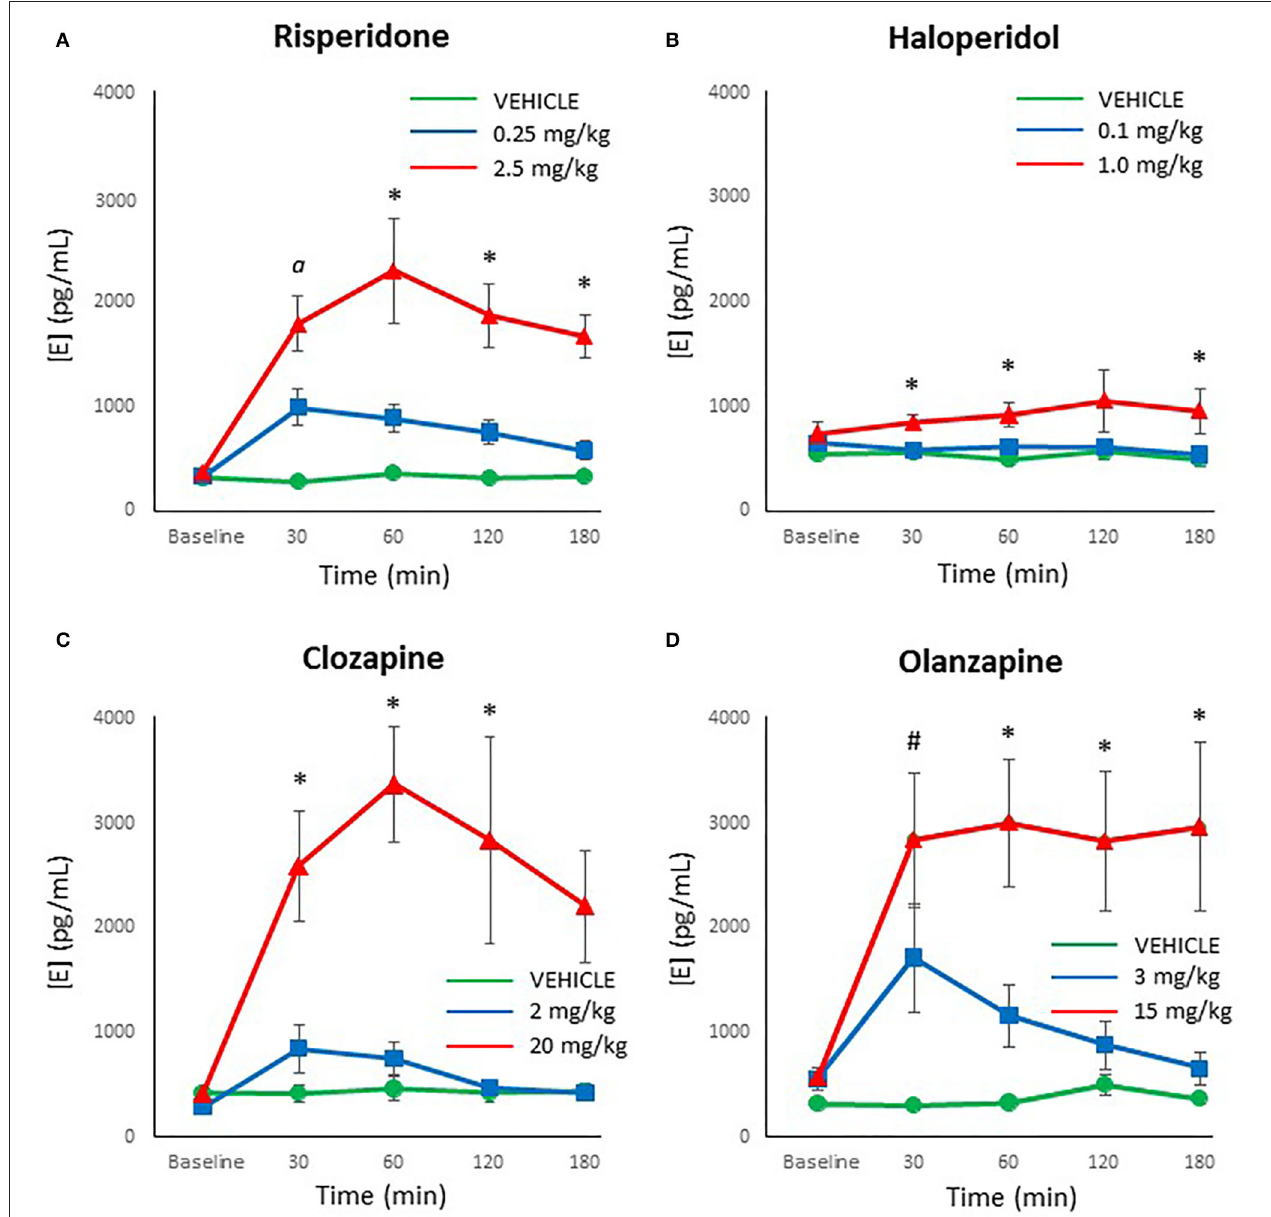
FIGURE 3 | Acute changes in plasma epinephrine (E) concentrations (pg/ml) after antipsychotic drug treatment in adult female rats. Animals ( n = 10 per group) were given a single IP injection of (A) risperidone (0.25 or 2.5 mg/kg) or (B) haloperidol (0.1 or 1.0 mg/kg) or (C) clozapine (2 or 20 mg/kg) or (D) olanzapine (3 or 15 mg/kg) or vehicle. Values are expressed in group means ± SEM. Plasma samples were collected immediately prior to drug treatment (Baseline) and at 30, 60, 120, and 180mins after treatment. α Statistically significant difference between all three groups, p < 0.05; * Statistically significant difference between high dose group and both other groups, p < 0.05; # Statistically significant difference between both drug treated groups and vehicle, p < 0.05.